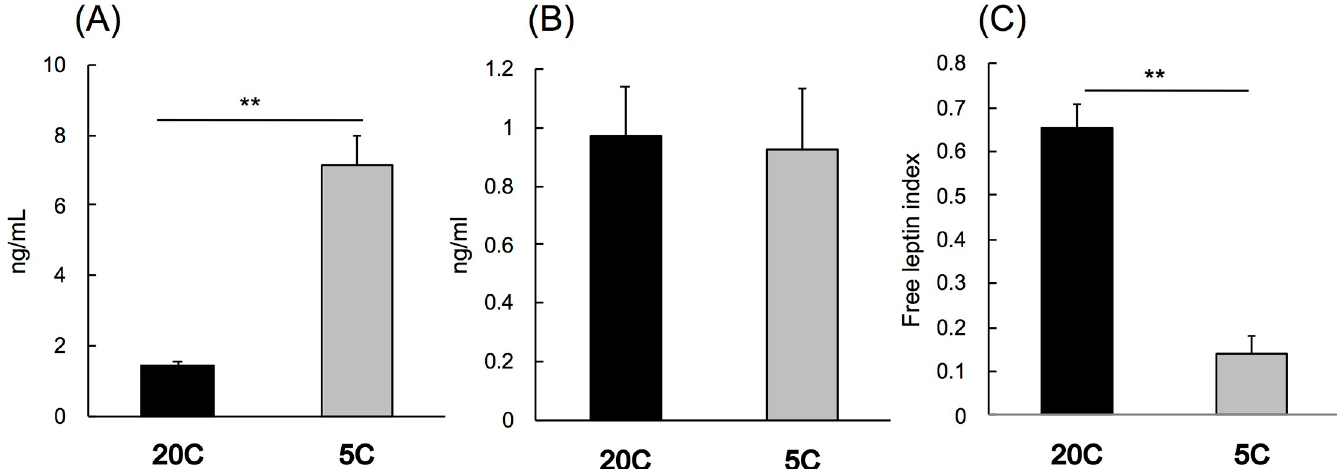
Fig 3. Effect of protein restriction on plasma leptin and leptin receptor in mice. C57BL/6 mice were fed 20C or 5C ad libitum for 7 d. Plasma sOb-R (A) and plasma leptin (B) concentrations were measured with ELISA. Free leptin index was calculated from plasma leptin and sOb-R (C). Results are expressed as means ± standard errors (n = 5). Statistical difference between the groups are shown as �� , P < 0.01.